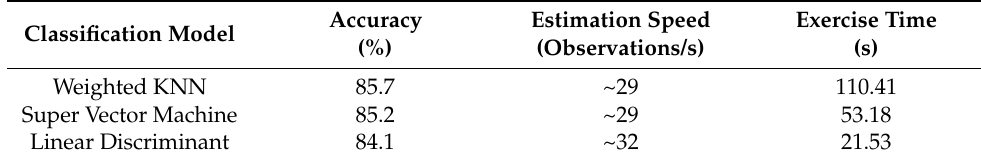
Figure 12. Confusion matrix for weighted KNN with testing accuracy: 86.96%. Several classifier evaluation performance indicators were used, such as accuracy (Ac), recall (Re), specificity (Sp), precision (Pr), sensitivity (Se), and F1 score. The classifi- cation performance of our proposed method is shown in Table 3. Table 3. Classification performance of weighted KNN classifier. Trial TP (%) FP (%)